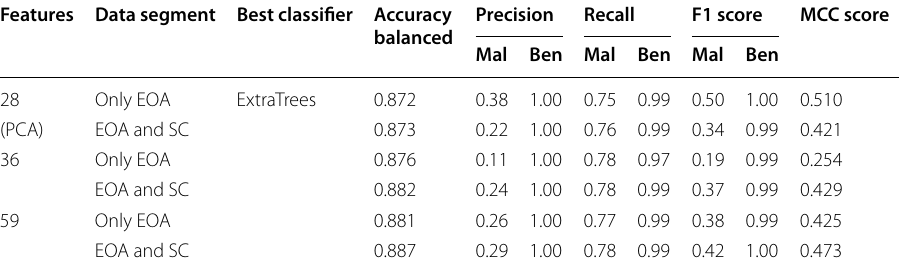
Table 2 Balanced accuracy, Precision, and Recall, and F1 score for both malicious (Mal) and benign (Ben) accounts with best identified ML algorithm for supervised case when using different dataset configurations